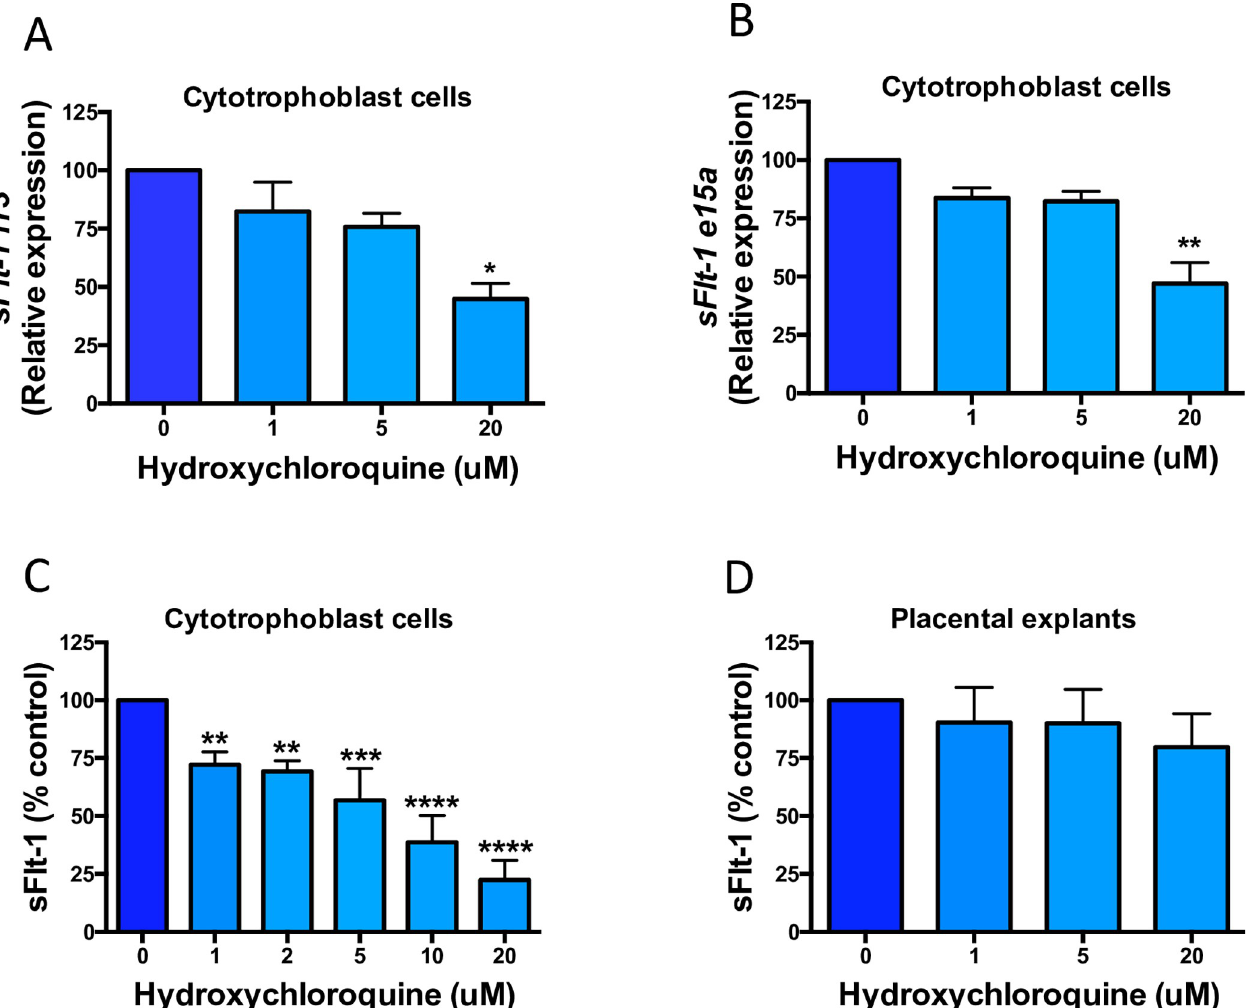
Fig 1. The effects of hydroxychloroquine on sFlt-1 gene expression and its secretion from cytotrophoblasts and explants of preeclamptic placentas. Treating cytotrophoblasts with hydroxychloroquine caused a significant reduction in both sFlt-1 variant isoforms sFlt-1 i13 (a) and sFlt-1 e15a (b) with a 20 μ M dose of hydroxychloroquine. This reduction translates into a significant decrease of sFlt-1 secretion from cytotrophoblasts (c) across all doses of the drug. Although not statistically significant, on average placental explants tended produce less sFlt-1 under treatment. Data are means ± SEM of minimum three independent experiments. � p < 0.05, �� p < 0.01, ��� p < 0.001, ���� p < 0.0001 (Friedman test).